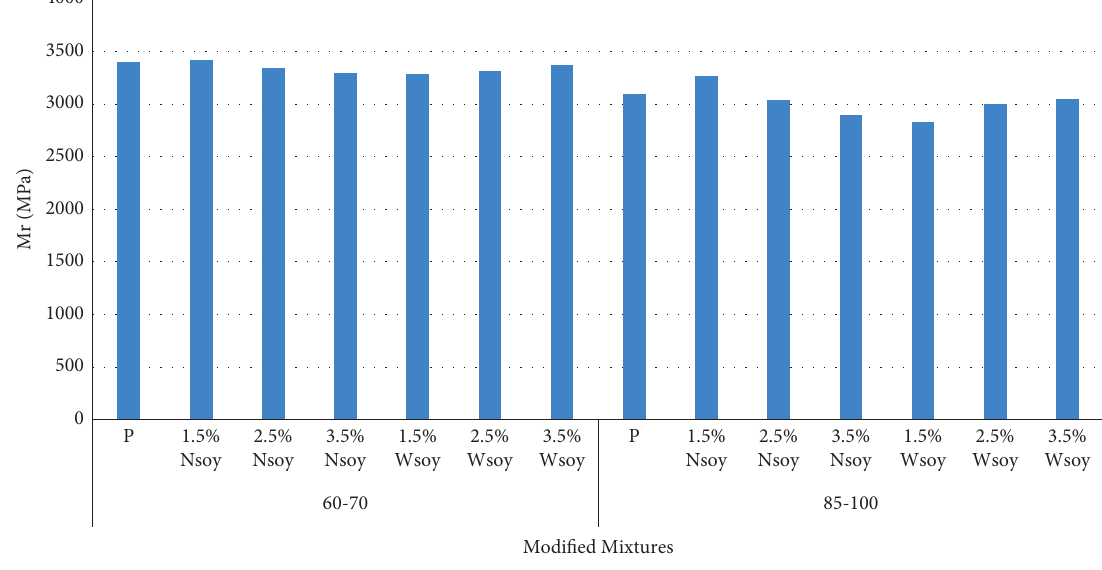
Figure 8: Results of unmodified and modified mixtures’ resilient modulus.